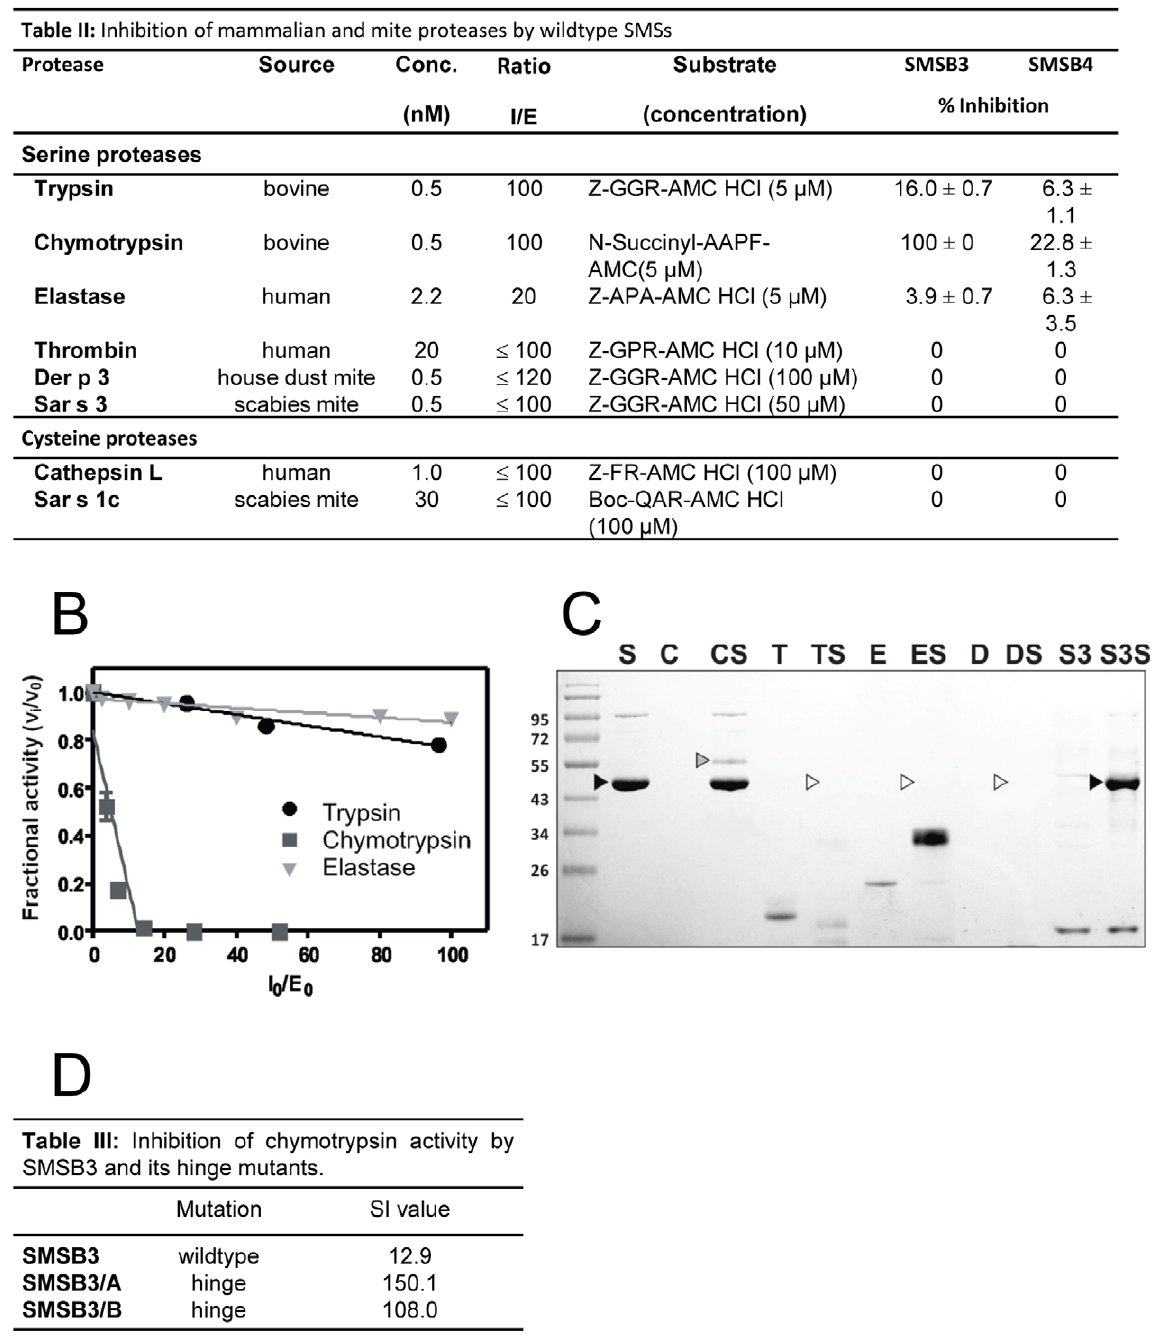
Figure 4. SMSs inhibit mammalian proteases and form serpin/protease complexes. ( A) Inhibitory profile of mammalian and mite proteases by wild type SMSs (overview). Proteases were pre-incubated with different concentrations of SMSB3 or SMSB4 at 37 u C for 10 min in the appropriate reaction buffer. The reaction was started by addition of the corresponding fluorescent aminomethyl-coumarin substrate and enzyme inhibition was measured as change in fluorescence in comparison with controls. Shown are means 6 SD (n=3). (B) Stoichiometry of inhibition for SMSB3. The inhibitory activity was assessed by measuring residual enzyme activities of trypsin, chymotrypsin and leucocyte elastase. Enzymes were incubated with a 2-120:1 molar excess of SMSB3 at 37 u C for 10 min in the appropriate reaction buffer. Residual enzyme activity was measured in triplicate (SD # 5%) by adding the appropriate aminomethyl-coumarin peptide substrate and determining the reaction velocity as change in fluorescence. The fractional activity was the ratio of the velocity of inhibited enzyme (v i ) over the velocity of uninhibited control (v o ). The initial inhibitor/enzyme ratios ([I 0 ]/[E 0 ]) represent the molar excess of serpin over enzyme. ( C) Complex formation between SMSB3 and serine proteases. Serpin/protease complexes were analyzed by SDS-PAGE under non-reducing conditions after pre-incubation of SMSB3 (black arrow) with each protease at 37 u C for 15 min at serpin/protease ratios of 4:1. Covalent complex formation was found with chymotrypsin (grey arrow), while SMSB3 was